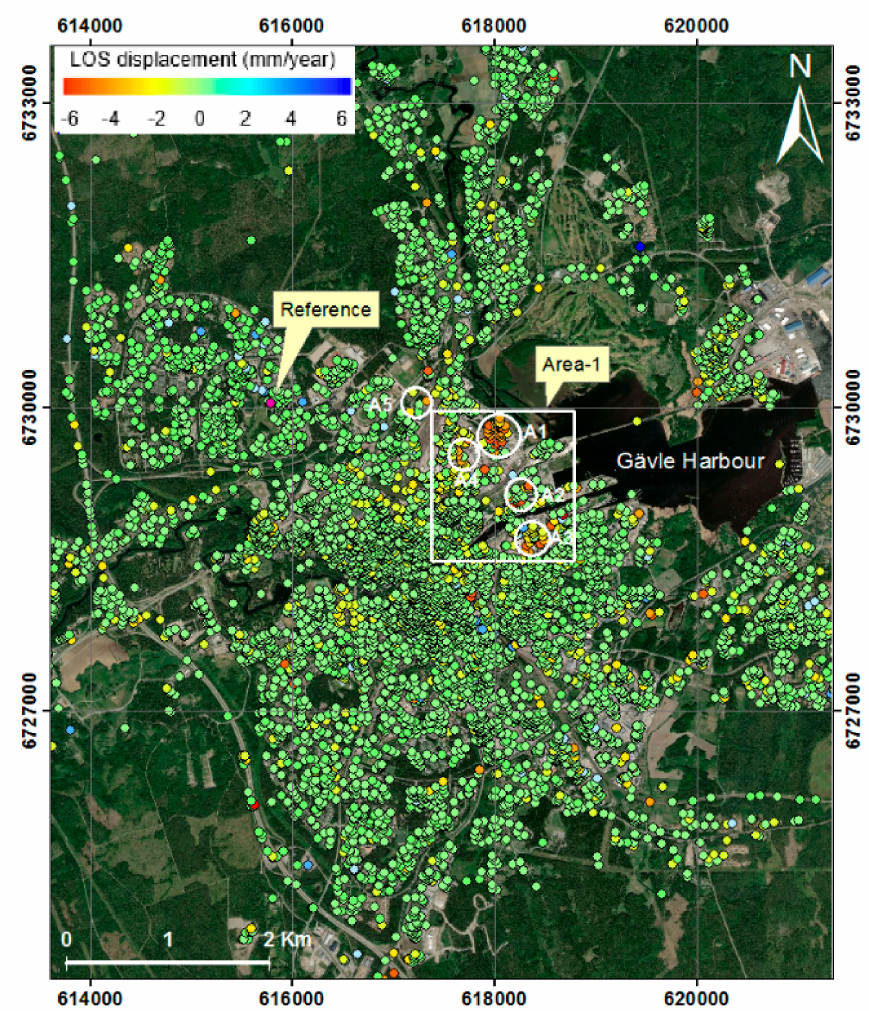
Figure 3. Line of Sight (LOS) displacement rates of all generated ascending PS points in Gävle city relative to the reference point (pink color). Area-1 shows the maximum displacement zone. A1–A5 refer to the five di ff erent small areas. The observation period is from January 2015 to May 2020. Coordinate system: SWEREF